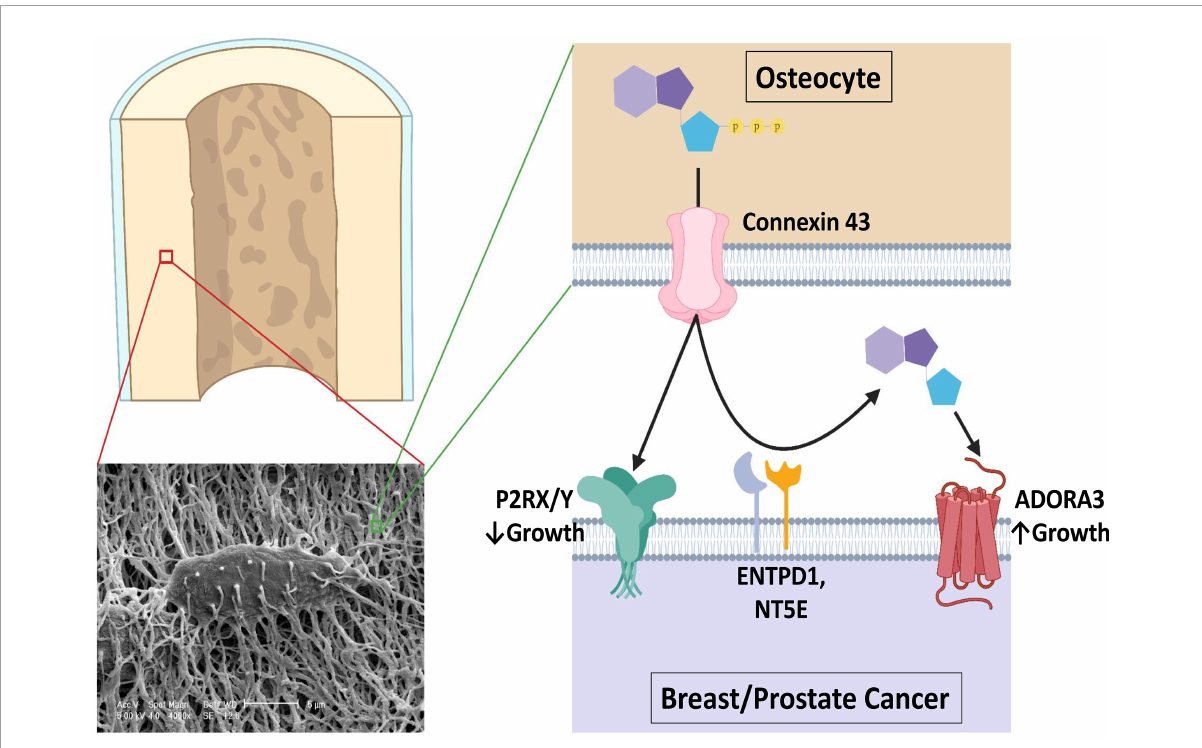
FIGURE8 A proposed model of the role of purinergic signaling in breast and prostate cancer bone colonization. An estimated 42 billion human osteocytes reside in a lacuna-canalicular network with an estimated surface area of 215 m2 and an extracellular volume of 24 ml (70). Connexin 43 hemichannel activity is promoted by bisphosphonate treatment and in response to shear stress such as seen in exercise, through which ATP is released that usually inhibits breast and prostate cancer growth in bone through ATP receptor stimulation. However, CD39 and CD73